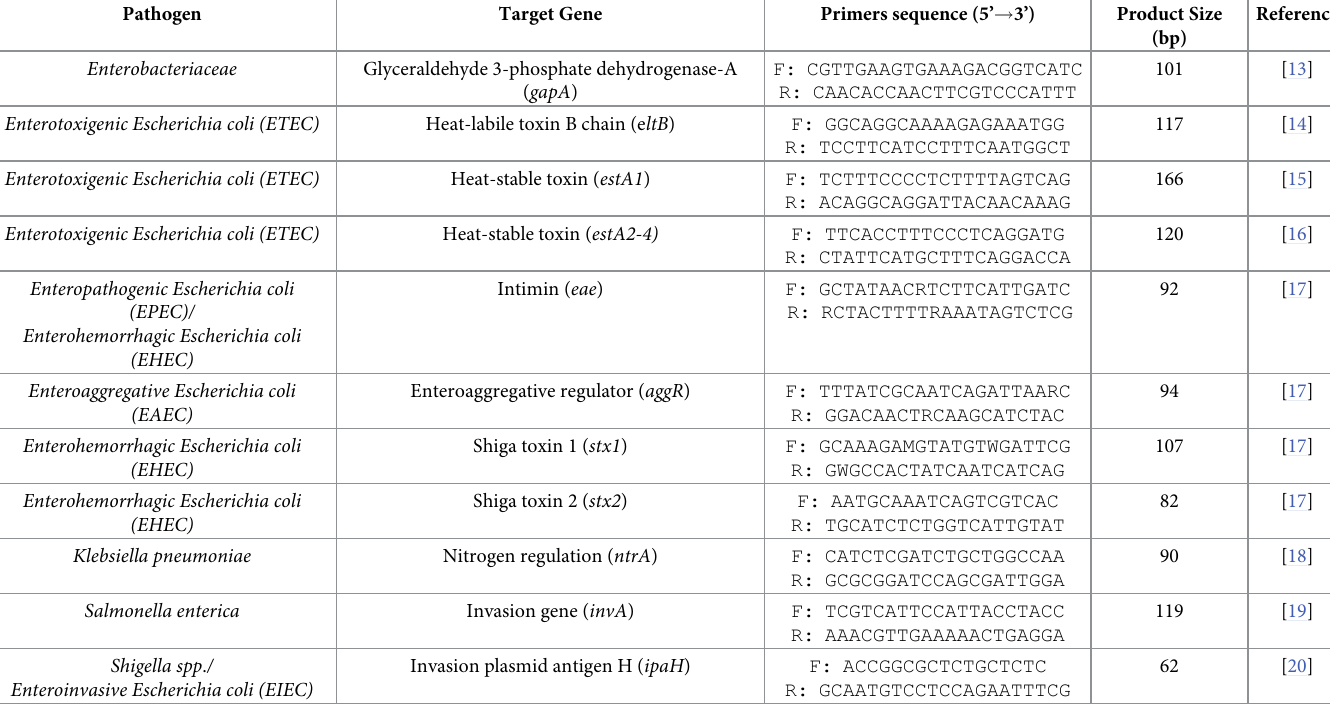
Table 1. List of oligonucleotide primers for real-time PCR detection of diarrheal bacterial pathogens.